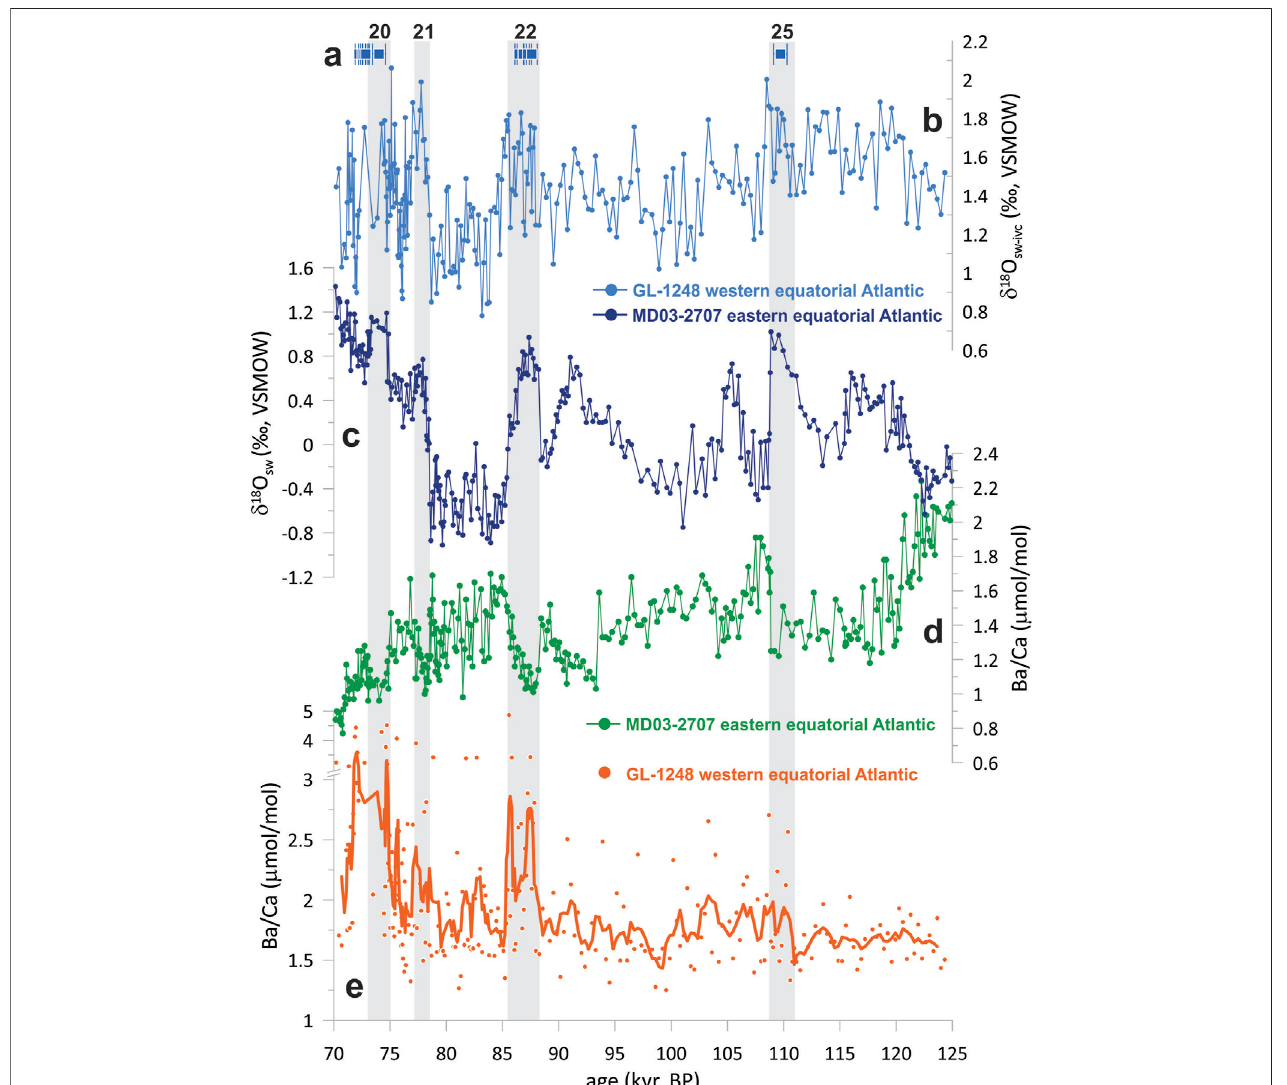
FIGURE 3 | Comparison of hydrological changes between eastern and western equatorial Atlantic. (A) Growth intervals of speleothem and travertine from northeasternBrazilwiththeirrespectivedatingerrors(Wang etal.,2004,bluesquares). (B) δ 18 O sw-ivc of Globigerinoidesruber (white) fromcoreGL-1248(lightblueline). (C) δ 18 O sw of Globigerinoidesruber (pink)from core MD03-2707(dark blue line,Weldeab et al., 2007). (D) Ba/Ca ratiosof Globigerinoides ruber (pink) from coreMD03- 2707 (green line, Weldeab et al., 2007). (E) Ba/Ca ratios of Globigerinoides ruber (white) from core GL-1248 (orange line). Ba/Ca results are shown as 5-point running-average of the data points. Dansgaard-Oeschger stadials are marked by the grey bars.